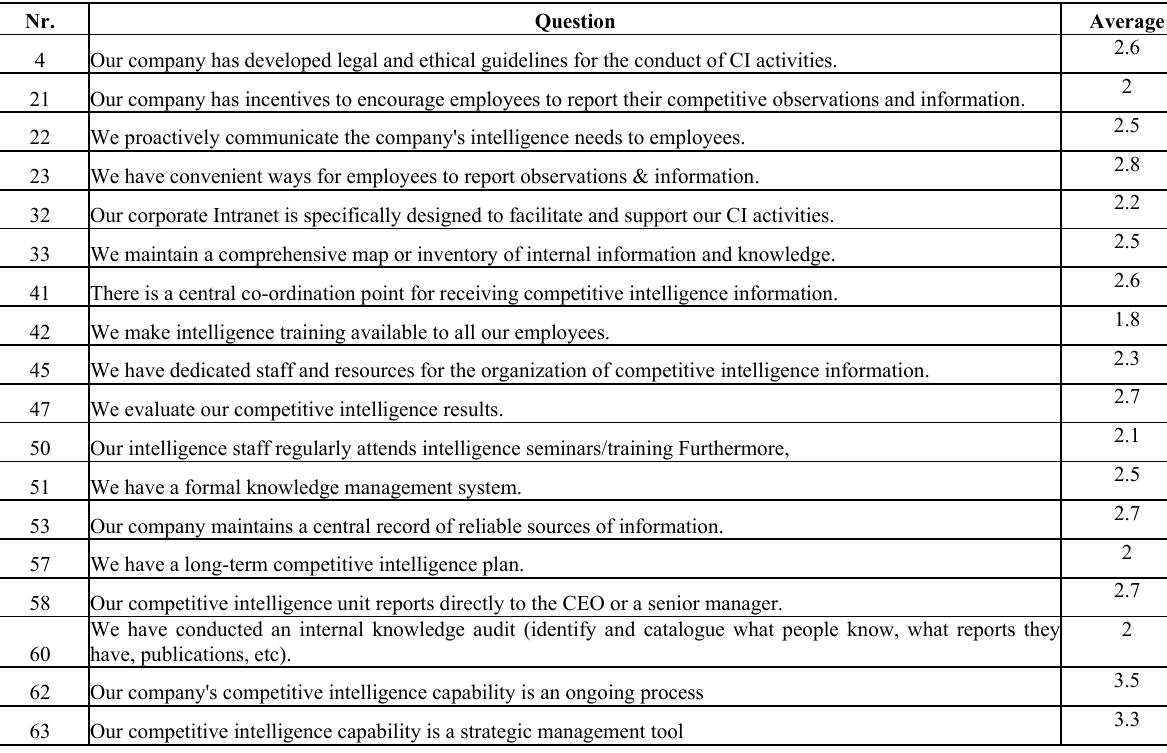
Table 6: Results of process and structure questions Nr.